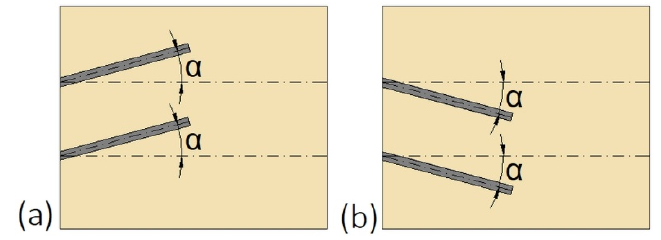
Figure 15. The inclination angle α of fins: ( a ) Upward; ( b ) downward [139].